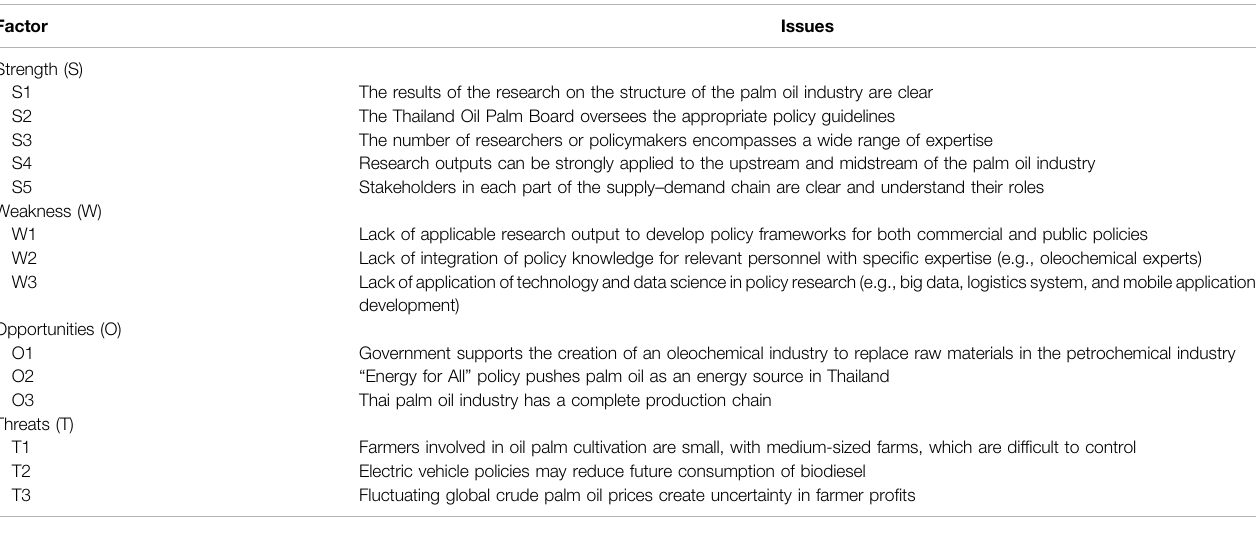
TABLE 1 | SWOT analysis on palm oil management policy.